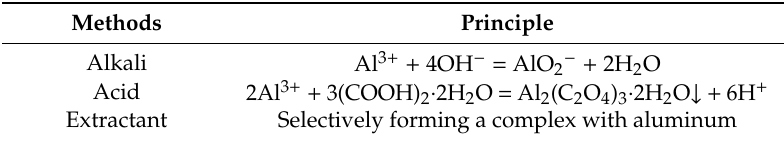
Table 1. Traditional methods of aluminum